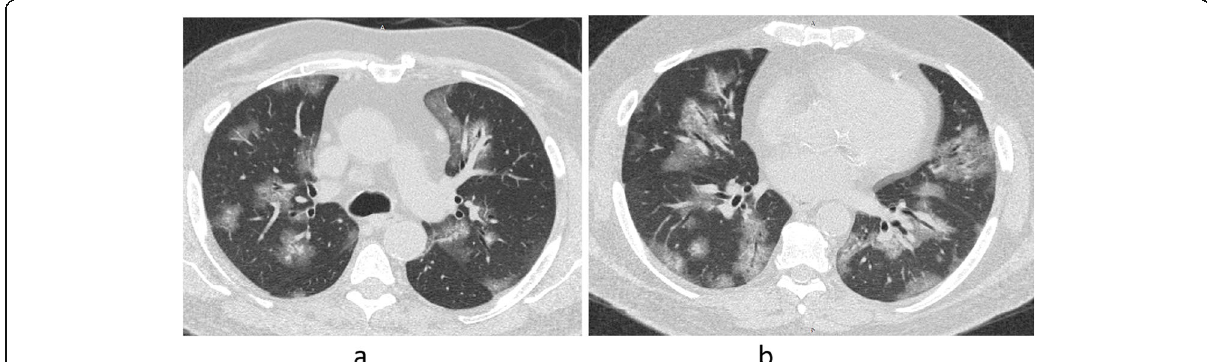
Fig. 2 A 65-year-old male patient: ( a , b ) axial CT lung window at different levels showed multiple scattered irregular patchy ground-glass lesions with crazy-paving